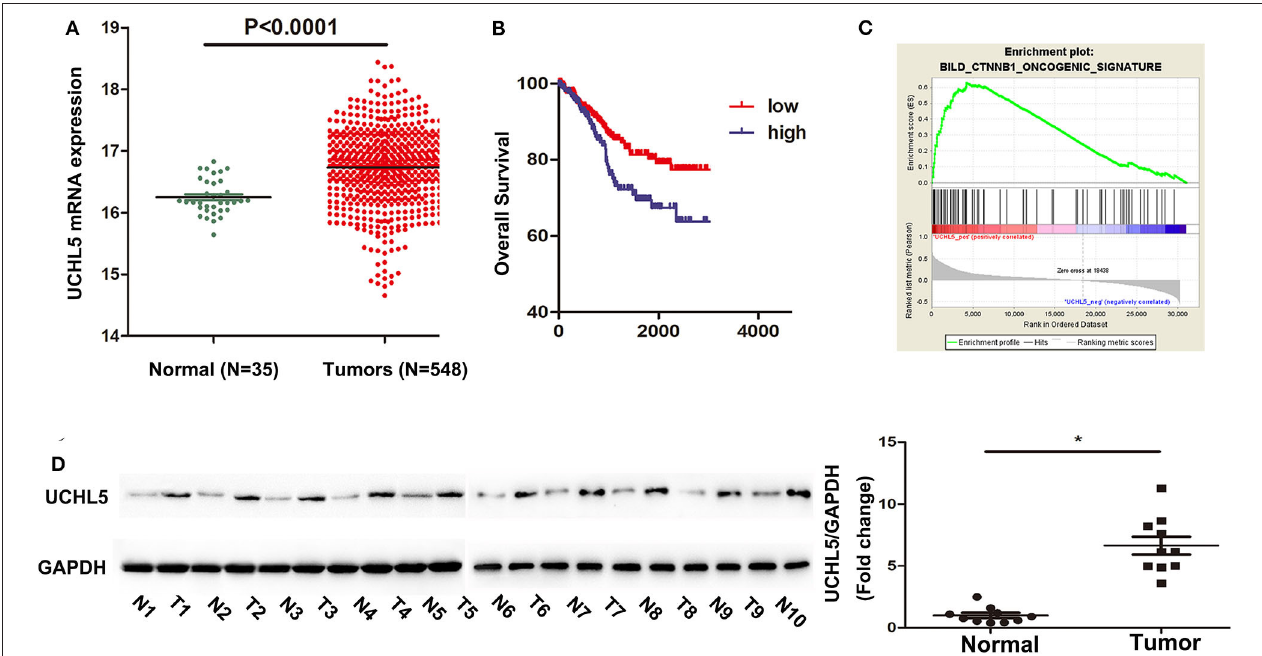
FIGURE 1 | The expression of UCHL5 was significantly increased in EC tissues and negatively correlated with overall survival. (A) The relative levels of UCHL5 mRNA expression between EC tissues ( N = 548) and non-tumor specimens ( N = 35) were obtained from the TCGA database. (B) Overall survival (OS) was analyzed between patients with high UCHL5 and low UCHL5 expression in the TCGA website. (C) Representative image of gene set enrichment plots. (D) Western blot detected the expression of UCHL5 protein between 10 EC tissues (abbreviated to “T”) and matched adjacent normal tissues (abbreviated to “ N ”) ( N = 10). * P < 0.05 vs. matched adjacent normal tissues.